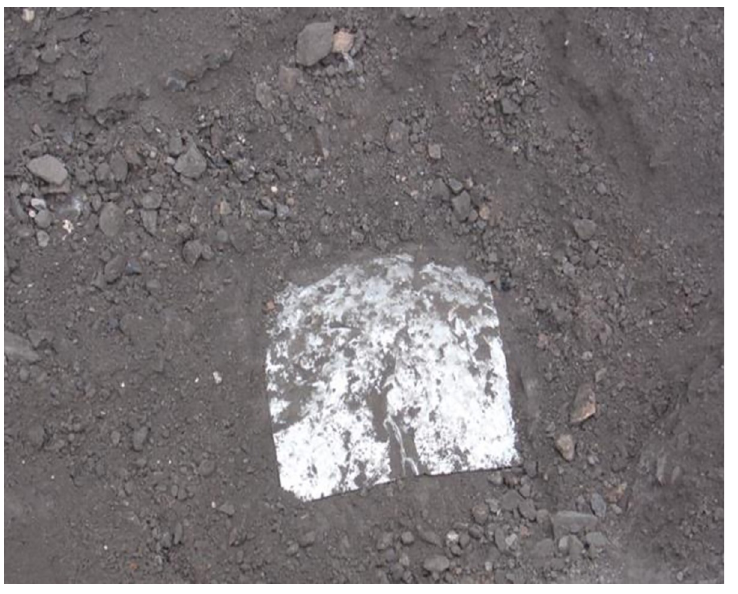
Fig 6. Location of steel plate.